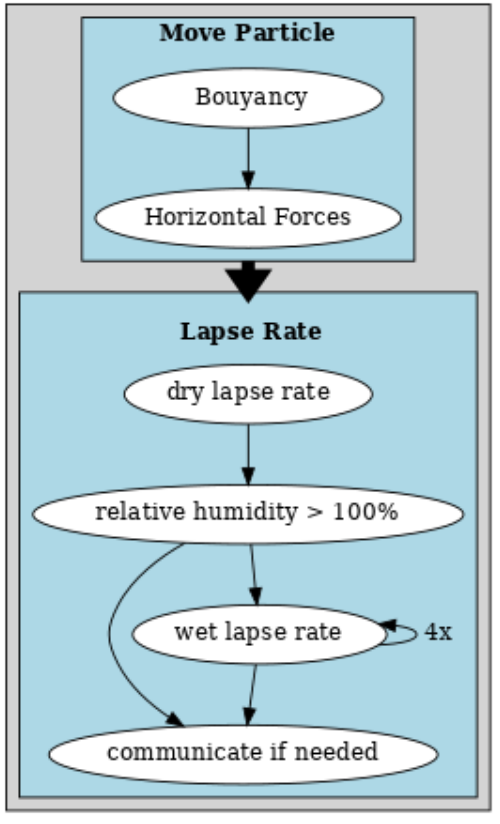
Figure 7. Overview of the computational phase of a